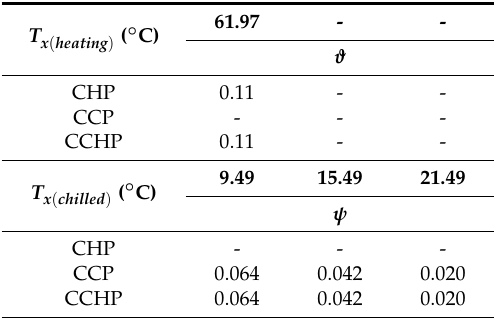
Table 7. ϑ and ψ parameter related to heating and cooling production